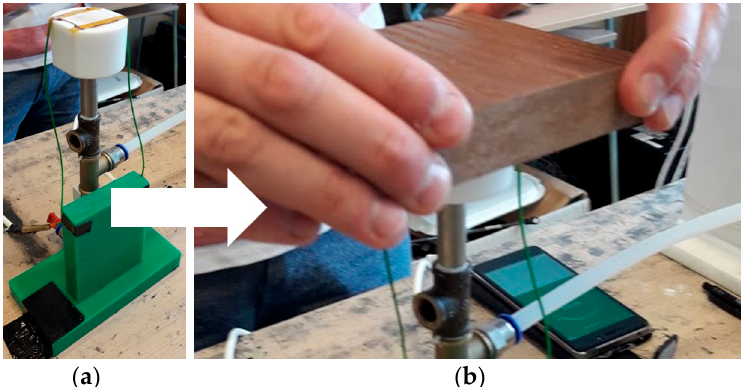
Figure 3. Plasma surface treatment: ( a ) Portable source of Multi-Hollow Surface Dielectric Barrier Discharge plasma; ( b ) Surface Treatment of the test sample (here with WPC_45/45).